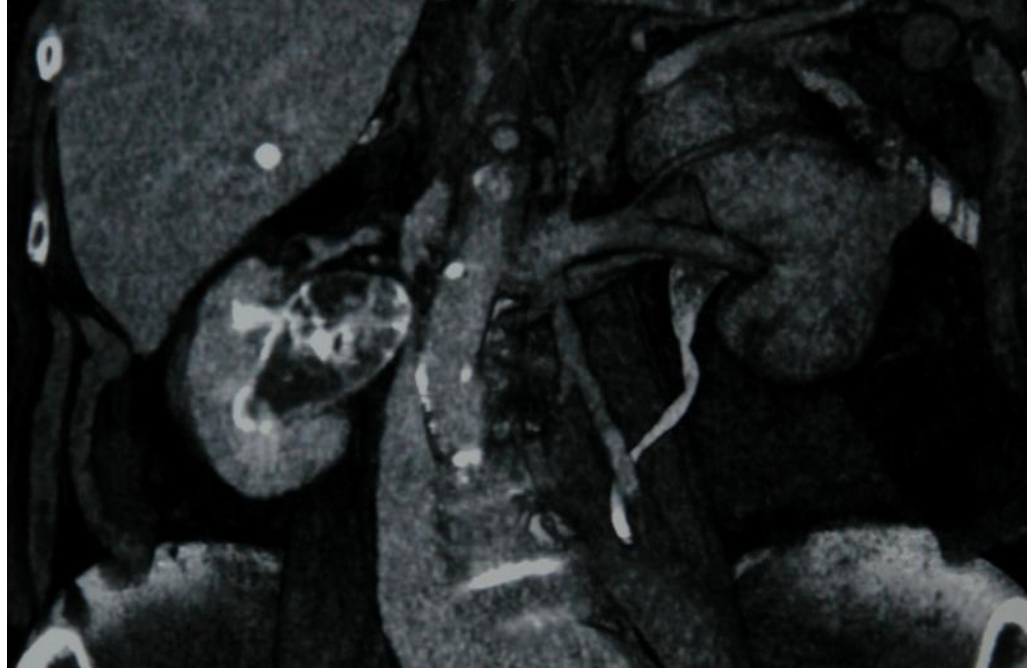
FIGURE 4. CT urography: the right renal pelvis is partially filled with water-like and positive- density material, mixed with small calcifications and air